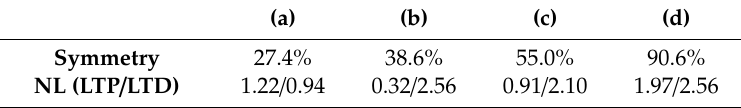
Table 2. Symmetry and non-linearity (NL) of the GST alloy and GT / ST iPCM